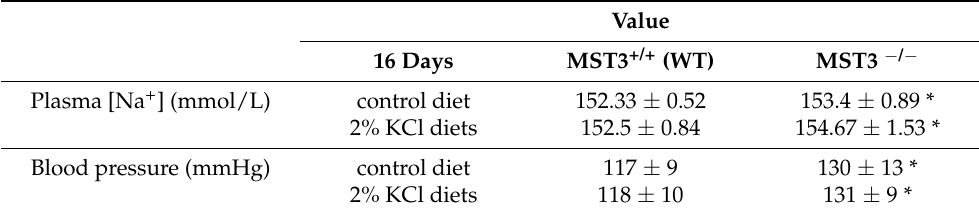
Table 2. Blood pressure (BP) in WT and MST3 − / − mice on control diets for 3 days and challenged with 2% KCl diets. * p < 0.05 vs. the WT